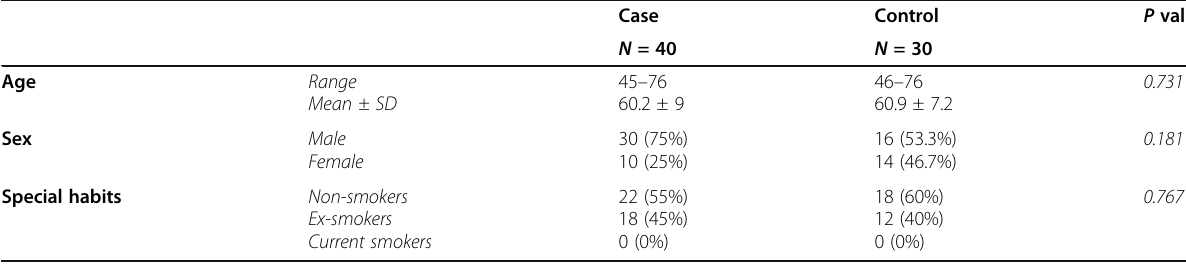
Table 1 Demographic data of all groups